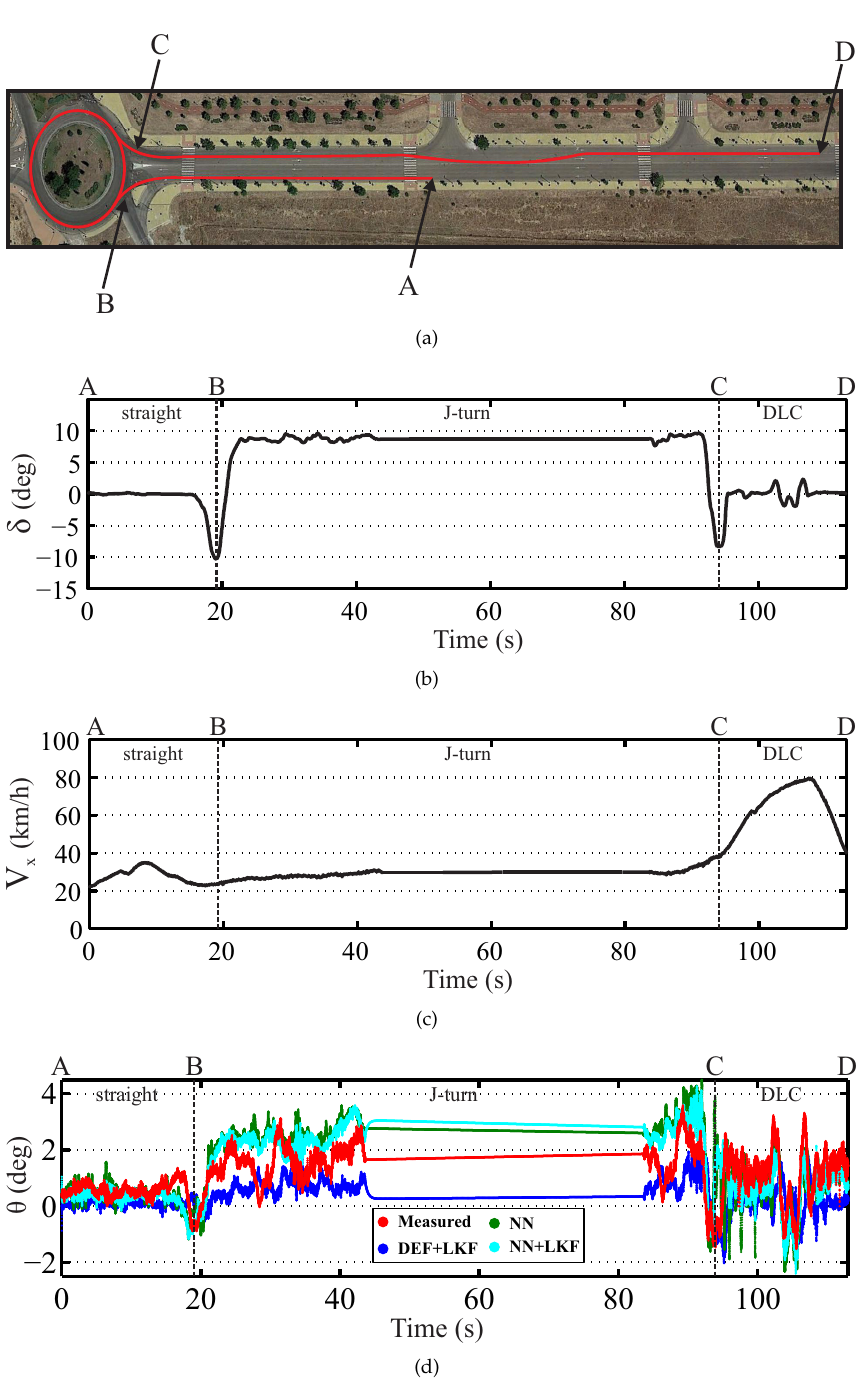
Figure 12. Experimental results for J-turn and DLC maneuvers (red points: measured; blue points: DEF + LKF; green points: NN; cyan points: NN + LKF): ( a ) the real environment and the vehicle trajectory, ( b ) the steering wheel angle profile, ( c ) the longitudinal vehicle speed profile and ( d ) the real and estimated roll